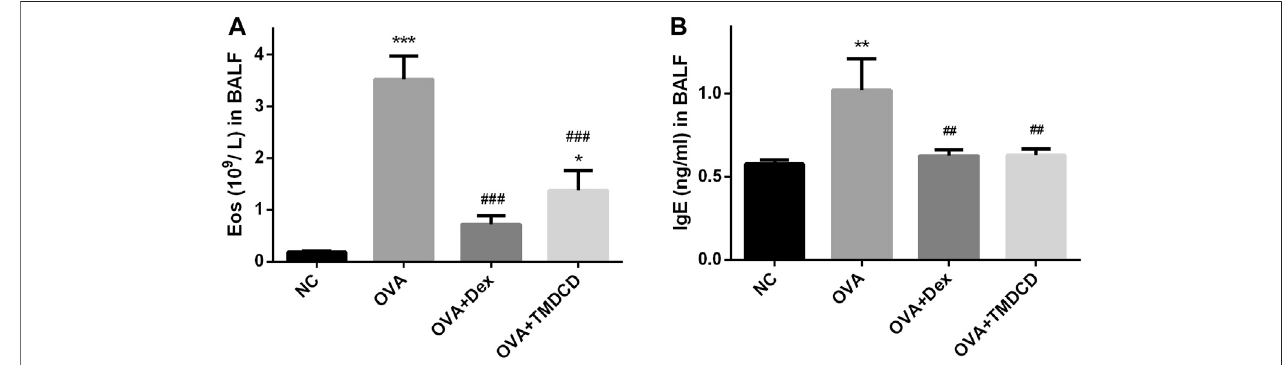
FIGURE 3 | The number of eosinophils and IgE level in BALF. (A) Eosinophils count. (B) The level of IgE was detected by ELISA. The results were expressed as Mean ± SEM. Compared with NC group, ** p < 0.01, *** p < 0.001, compared with OVA group, ## p < 0.01, ### p < 0.001 ( n (cid:2) 5